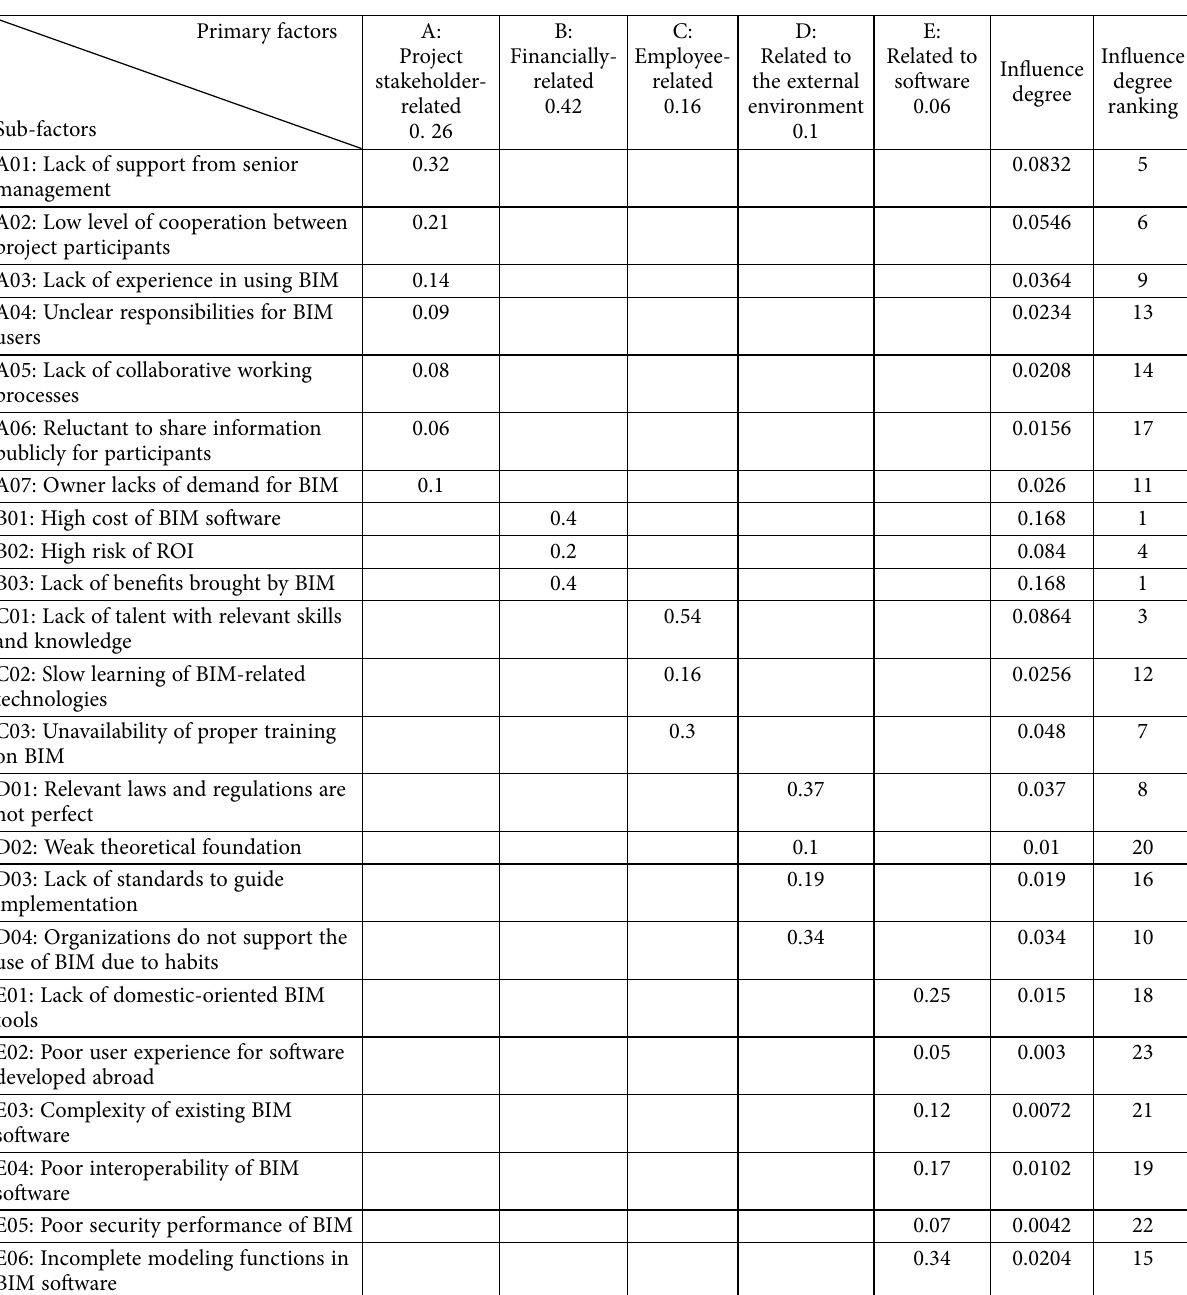
Table 12. Analysis of influence factors of barrier